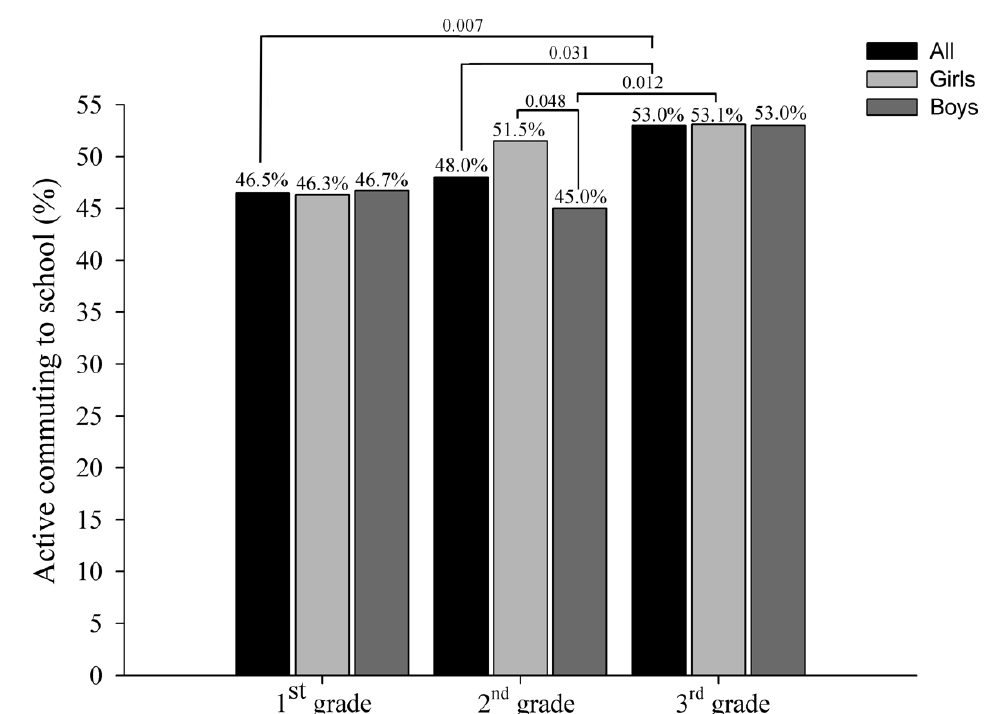
Figure 3. Active commuting to school by pre-primary education grade and gender. Table 2. Associations between active commuting to school and socio-economic